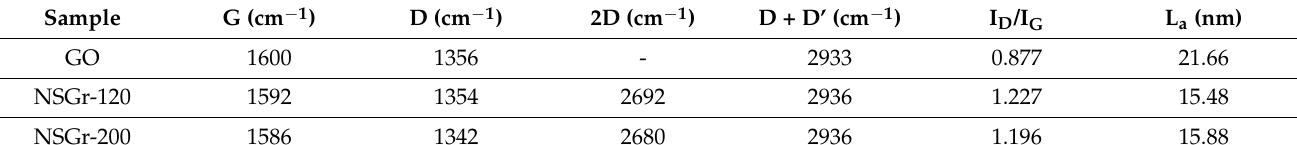
Table 2. Structural parameters obtained from the Raman bands of GO, NSGr-120, and NSGr-200 samples. Sample